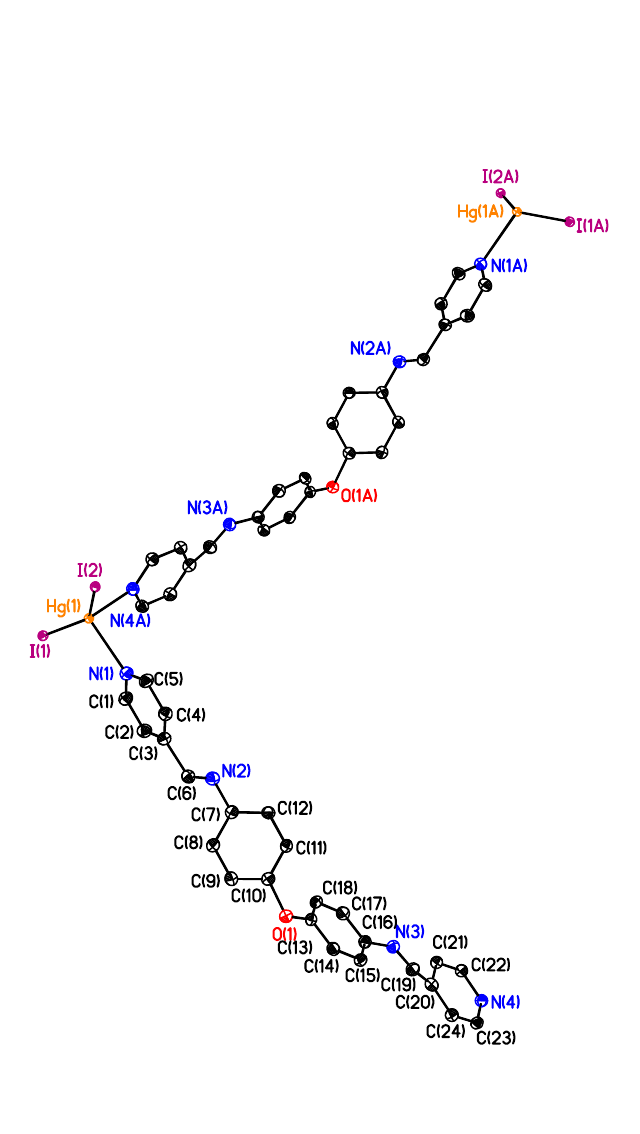
Figure 1. Molecular structure of 1 showing coordination geometry of Hg(II) ion. Hg(1)-N(1) 2.488(3), Hg(1)-N(4)#1 2.34(2), Hg(1)-I(1) 2.6588(6), Hg(1)-I(2) 2.6531(5) Å, N(4)#1-Hg(1)-N(1) 94.6(12), N(4)#1-Hg(1)-I(1) 100.5(11), N(1)-Hg(1)-I(1) 105.84(9), N(4)#1-Hg(1)-I(2) 103.0(9), N(1)-Hg(1)-I(2) 98.96(9), I(1)-Hg(1)-I(2) 144.044(14)°, symmetry code 1 = x-1/2, -y,